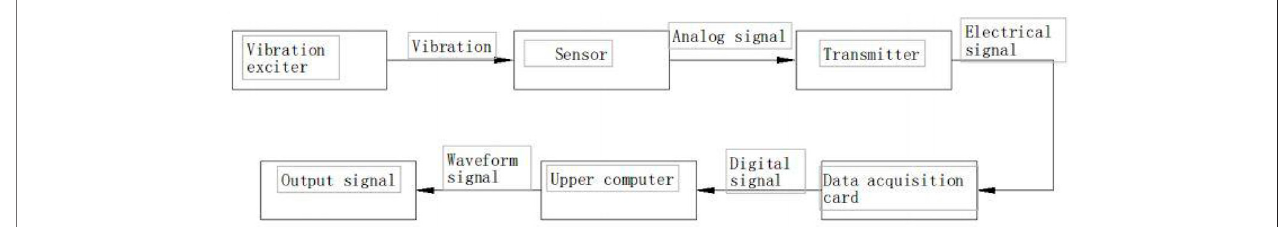
FIGURE 3 | Working principle.